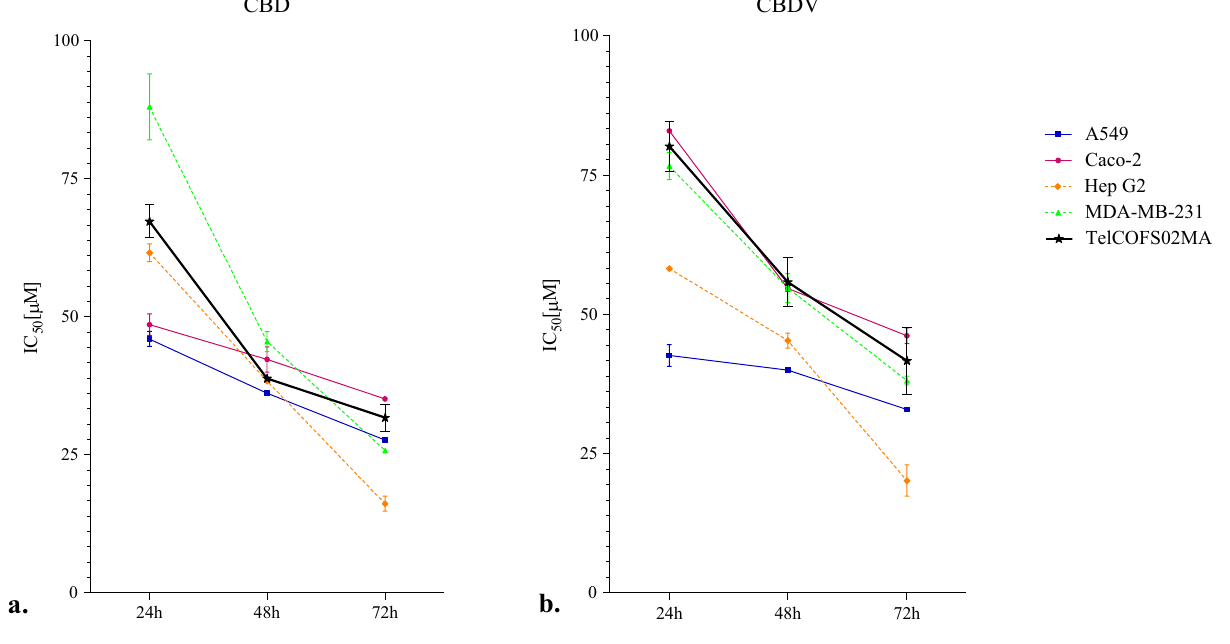
Figure 1. IC50 (µM) values obtained by MTT assay. IC50 (µM) values obtained by MTT assay of A549, Caco-2, Hep G-2, MDA-MB-231 and TelCOFS02MA cells after 24, 48, and 72 h of exposure: ( a ) CBD and ( b )